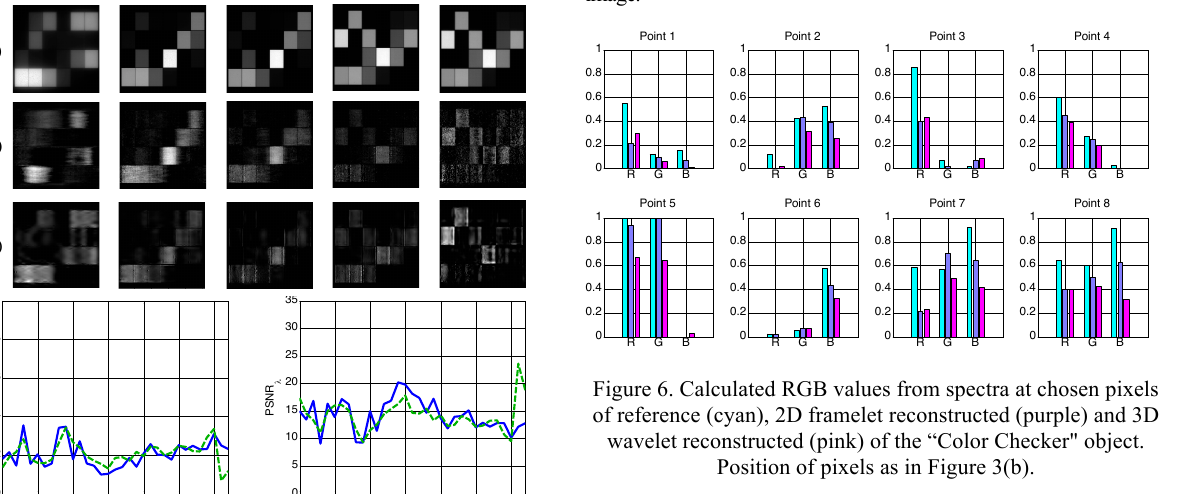
actual physical sensing matrix of the optical system with the diffuser, as well as due to the presence of actual noise in the experimental system.